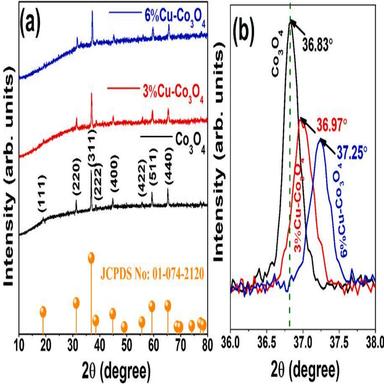
Comparison of XRD patterns of undoped Co3O4, 3%Cu–Co3O4, and 6%Cu–Co3O4 (a) and their enlarged (311) orientation peaks (b).